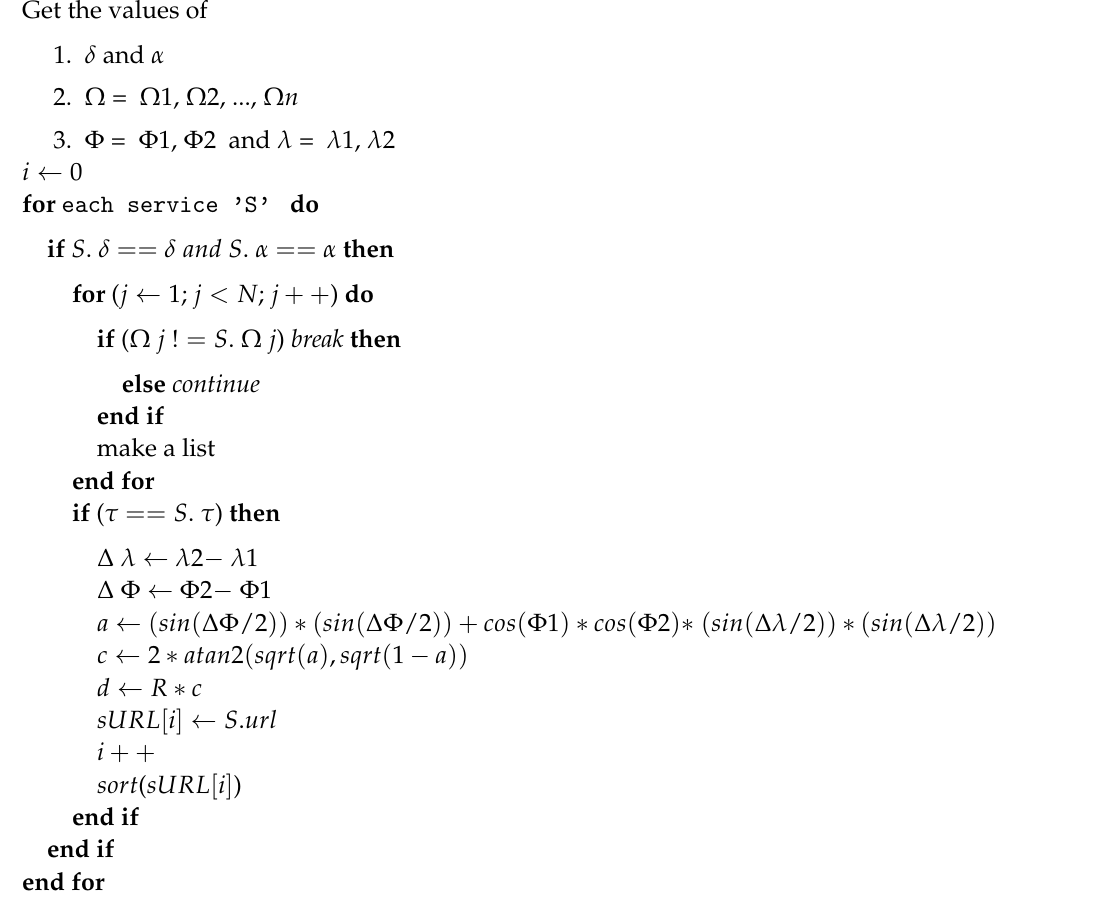
Algorithm 1 Services identification based on